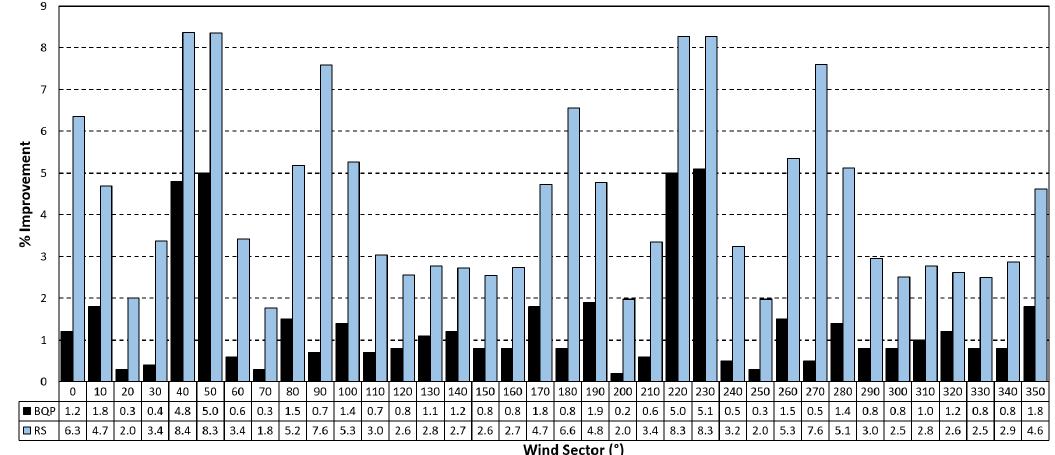
Figure 5. Percent improvement in power production by wind direction sector at D = 60 m with five different initial random